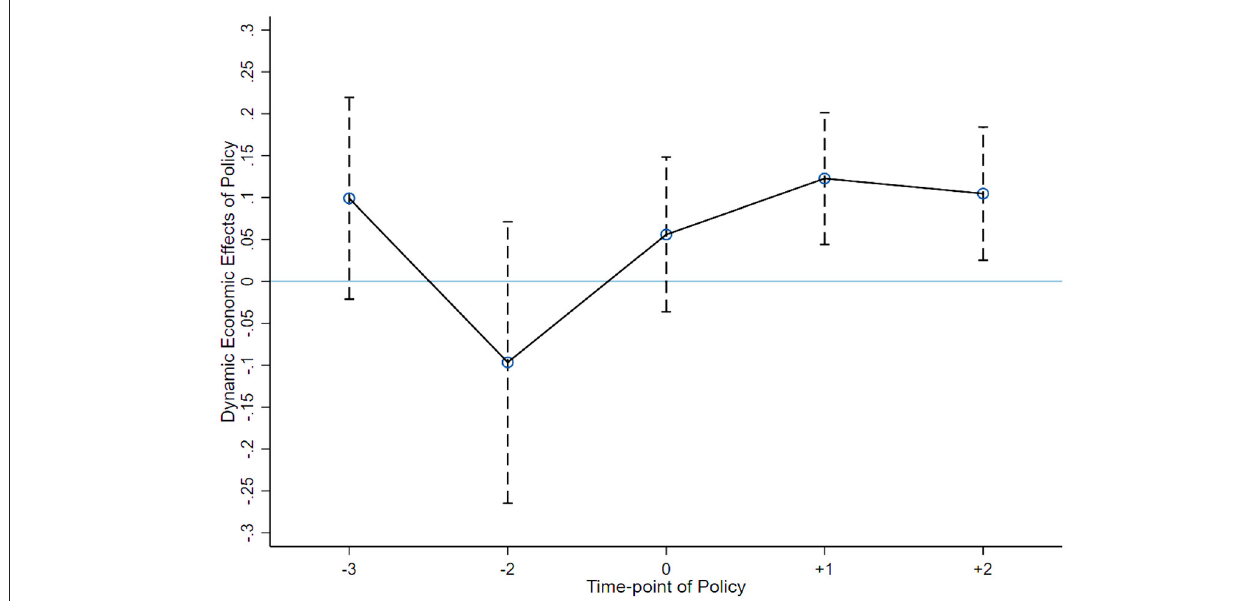
FIGURE 1 | Parallel